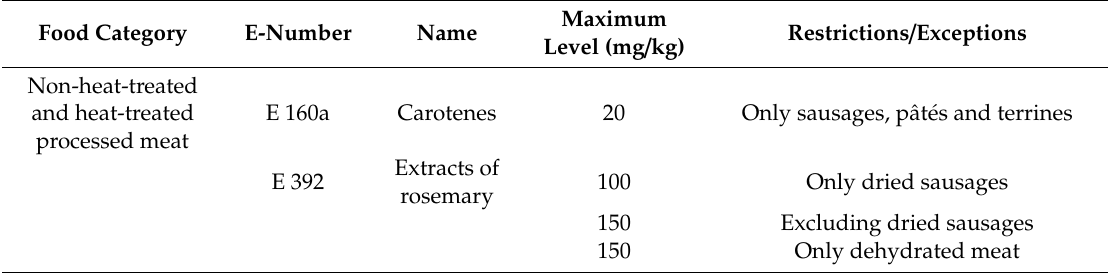
Table 3. Maximum levels of natural antioxidants permitted by the EU in meat and meat products. Food